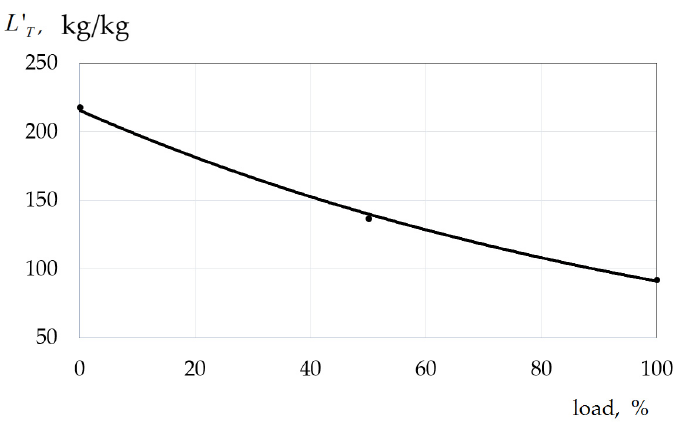
Figure 6. Dependence of the total amount of gases at α s on the load value.